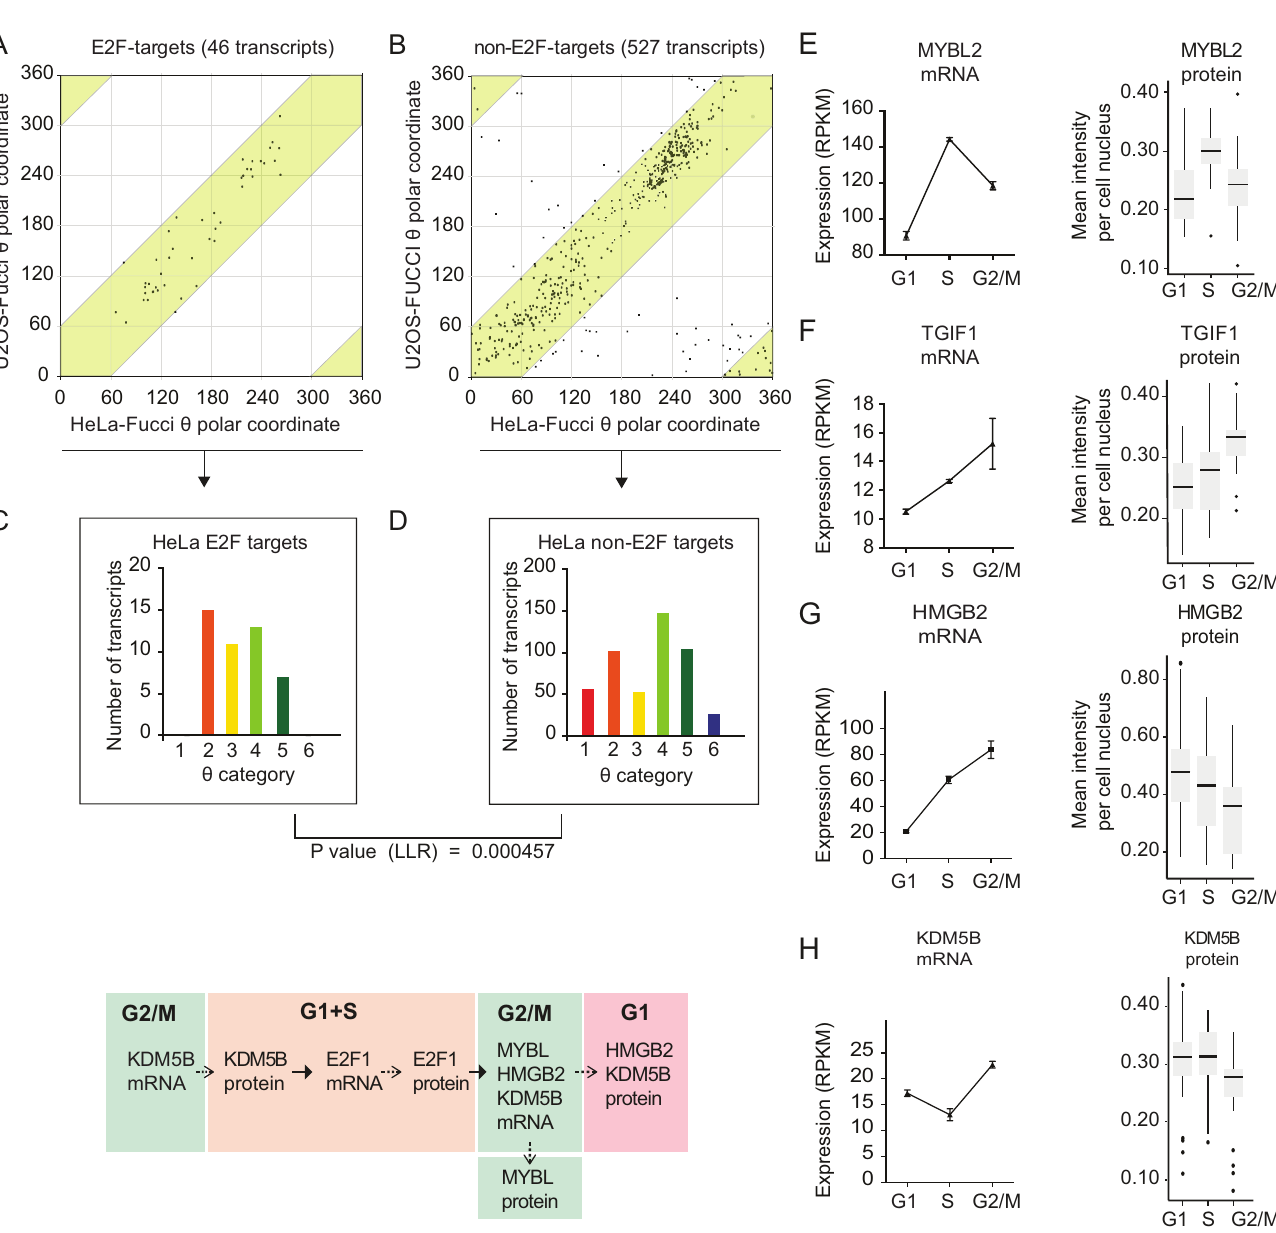
Fig 4. E2F1-controlled gene expression is compartmentalized. (A-D) Comparative analysisof E2F (A, C) and non-E2F targets (B, D) was performed using both the HeLa-Fucci and U2OS-Fucci cell cycle-dependent transcriptomes by plotting θ -values,with expressiongroups 2–5 highlightedby a pink box (A, B), and a distributionanalysiswith a log-likelihood ratio statistical comparisonusing the HeLa-Fucci cell θ -values(C, D). (E-H) mRNA expressionin the HeLa-Fucci data set (RPKM), and protein levels as Tukey boxplotsof averageantibodyintensitiesper cell nucleus, subdividedby cell cycle phaseaccordingto the quantification of Fucci reporters using fluorescent imaging. Error bars denoteSEM. (I) An exampleof known temporal relationships amongcell cycle-controlled TFs, verified by our data.